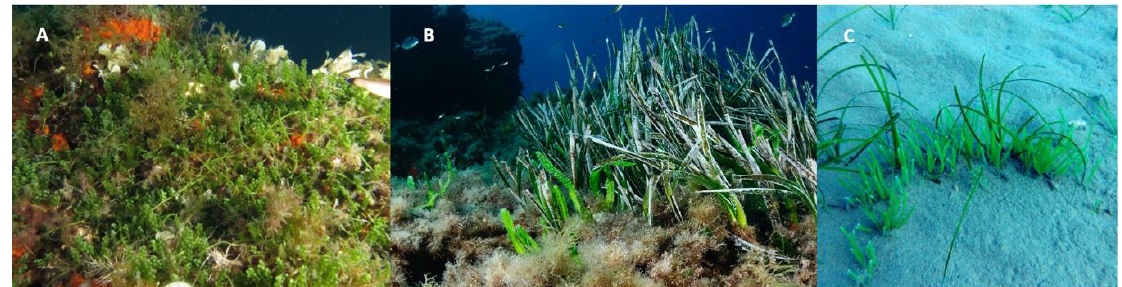
Figure 1. Caulerpa cylindracea with macroalgae and sponges (Secca del Toro — Favignana, 15 m depth; photo by Sergio Zanoni; from Reference [70]) ( A ). Caulerpa taxifolia in a Posidonia oceanica meadow (Strait of Messina, 12 m depth; photo by Alessandro Pagano; from Reference [70]) ( B ). Small patches of Caulerpa taxifolia var. distichophylla at Termini Imerese (photo by Marco Toccaceli; from Reference [56]) ( C ).